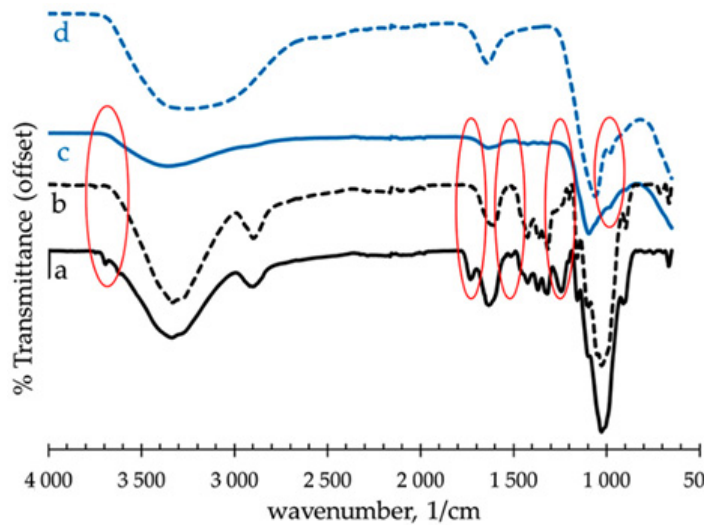
Figure 3. FTIR spectra of ( a ) untreated hemp; ( b ) NaOH-treated hemp; ( c ) NaOH + Al 2 (SO 4 ) 3 treated hemp; and ( d ) precipitate or residue from the spend solution of Al 2 (SO 4 ) 3 treatment. Reprinted from Reference [51] under open access license.